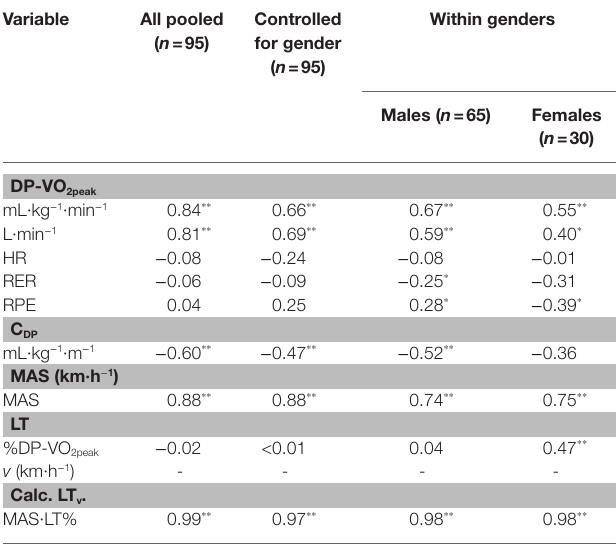
TABLE 3 | Baseline correlations with LT v .